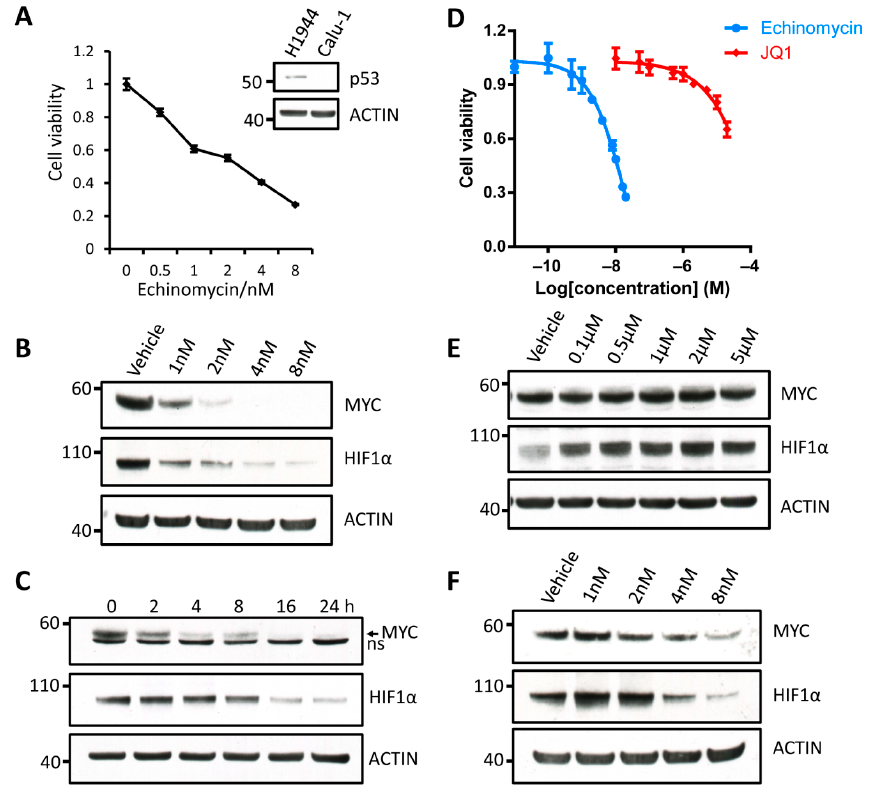
Figure 4. Degradation of MYC and HIF1 α induced by echinomycin is p53 and LKB1 independent. ( A ) Cell viability and proliferation assays by MTT in Calu-1 cells. Calu-1 cells were treated with echinomycin for 48 h, and then cell viability and proliferation were checked by incubating with MTT overnight ( n = 3 replicates). Insert shows the expression of p53 in H1944 and Calu-1 by western blot. ( B , C ) Protein levels of MYC and HIF1 α were analyzed in Calu-1 cells treated with different concentrations of echinomycin for 24 h ( B ) or treated with 4 nM echinomycin for indicated time ( C ). ns: